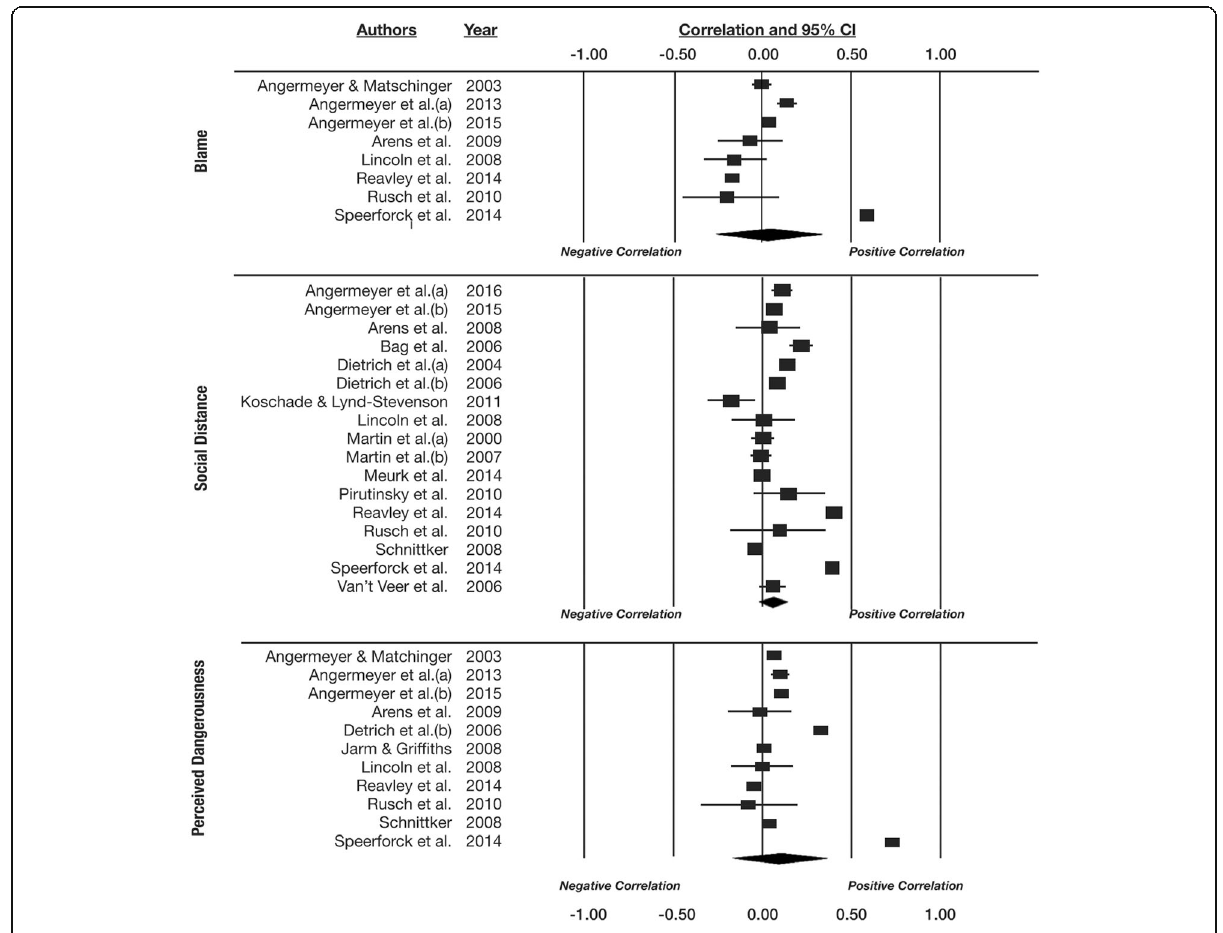
Fig. 3 Plots show meta-analyses of the correlational studies